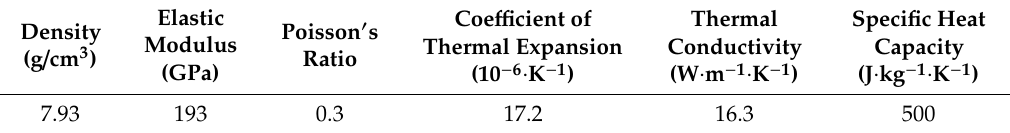
Table 1. Chemical composition of AISI 304. Reproduced from [2], with permission from Elsevier, 2009. Table 2. Physical properties of AISI 304. Reproduced from [2], with permission from Elsevier, 2009.